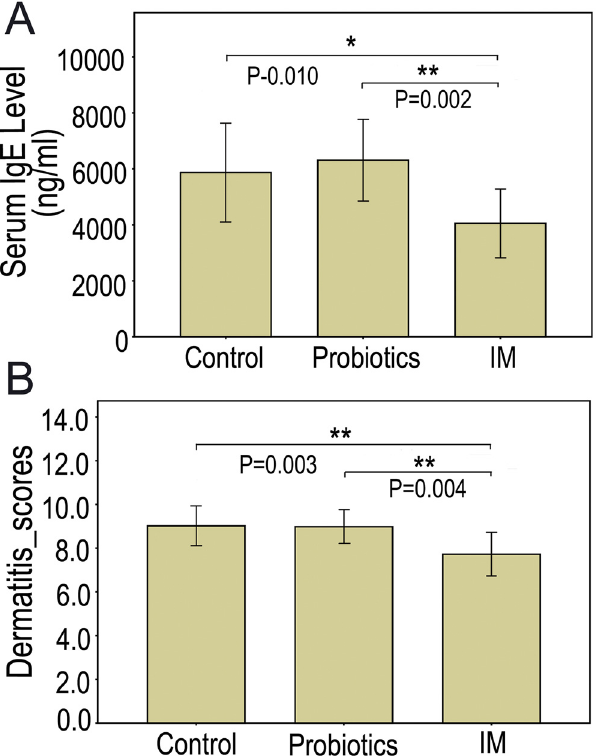
Fig 2. Effects of exposure to different concentrations of microbes. (A) Total serum IgE levels; (B) Dermatitis scores of rostral back and ear in BALB/c mice treated with DNFB. Serum absorbance in each group was averaged and each bar represents mean ± SEM (n = 10; * p < 0.05, ** p < 0.01, based on a two- tailed least significant difference